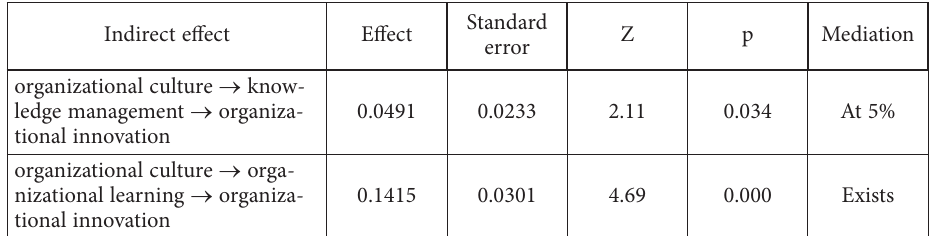
Table 8. Normal theory